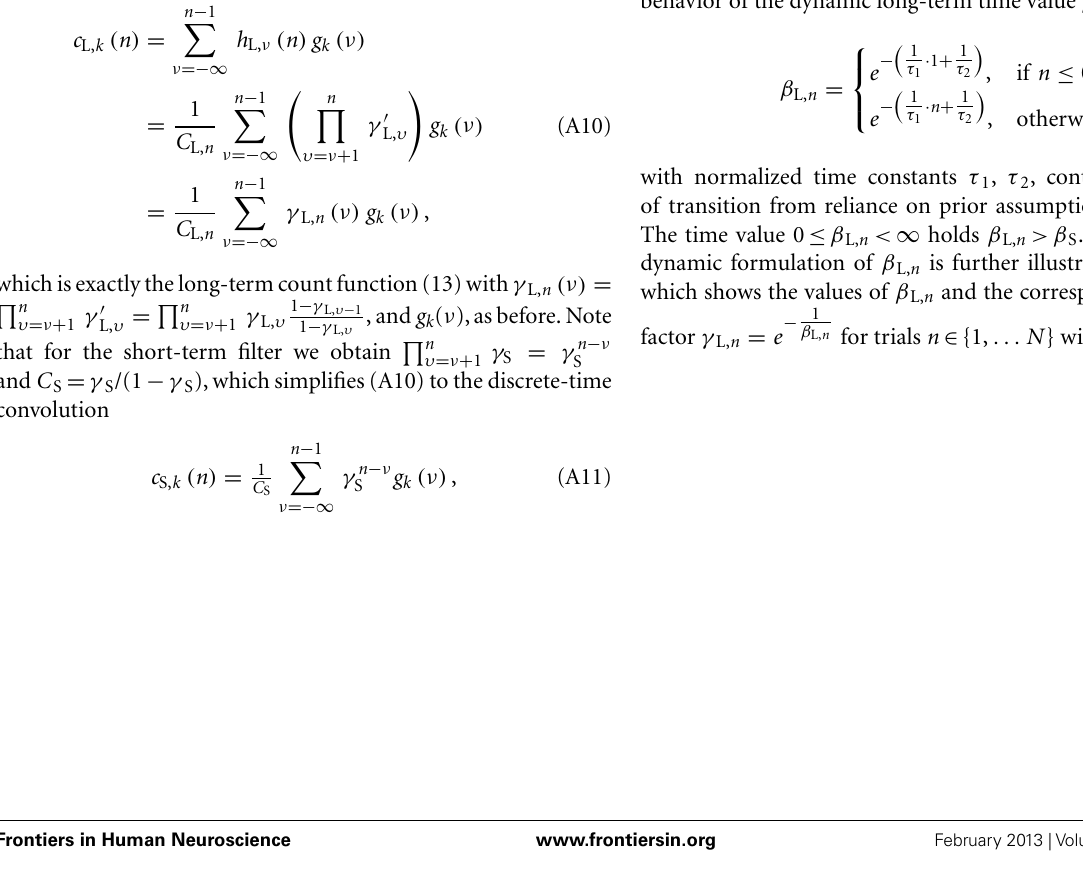
FIGUREA1 | Illustration of the equivalence of the digital filter (14) (Figure 3) to the count function as in (13). (A) Block diagram of the DIF model’s long-term memory filter of Figure 3 and (14) with input signal g k ( n ) and output signal c L,k ( n ). (B) Block diagram of a filter equivalent to (A) , where the multiplier (1 − γ L, n − 1 ) has been moved to the right. (C)